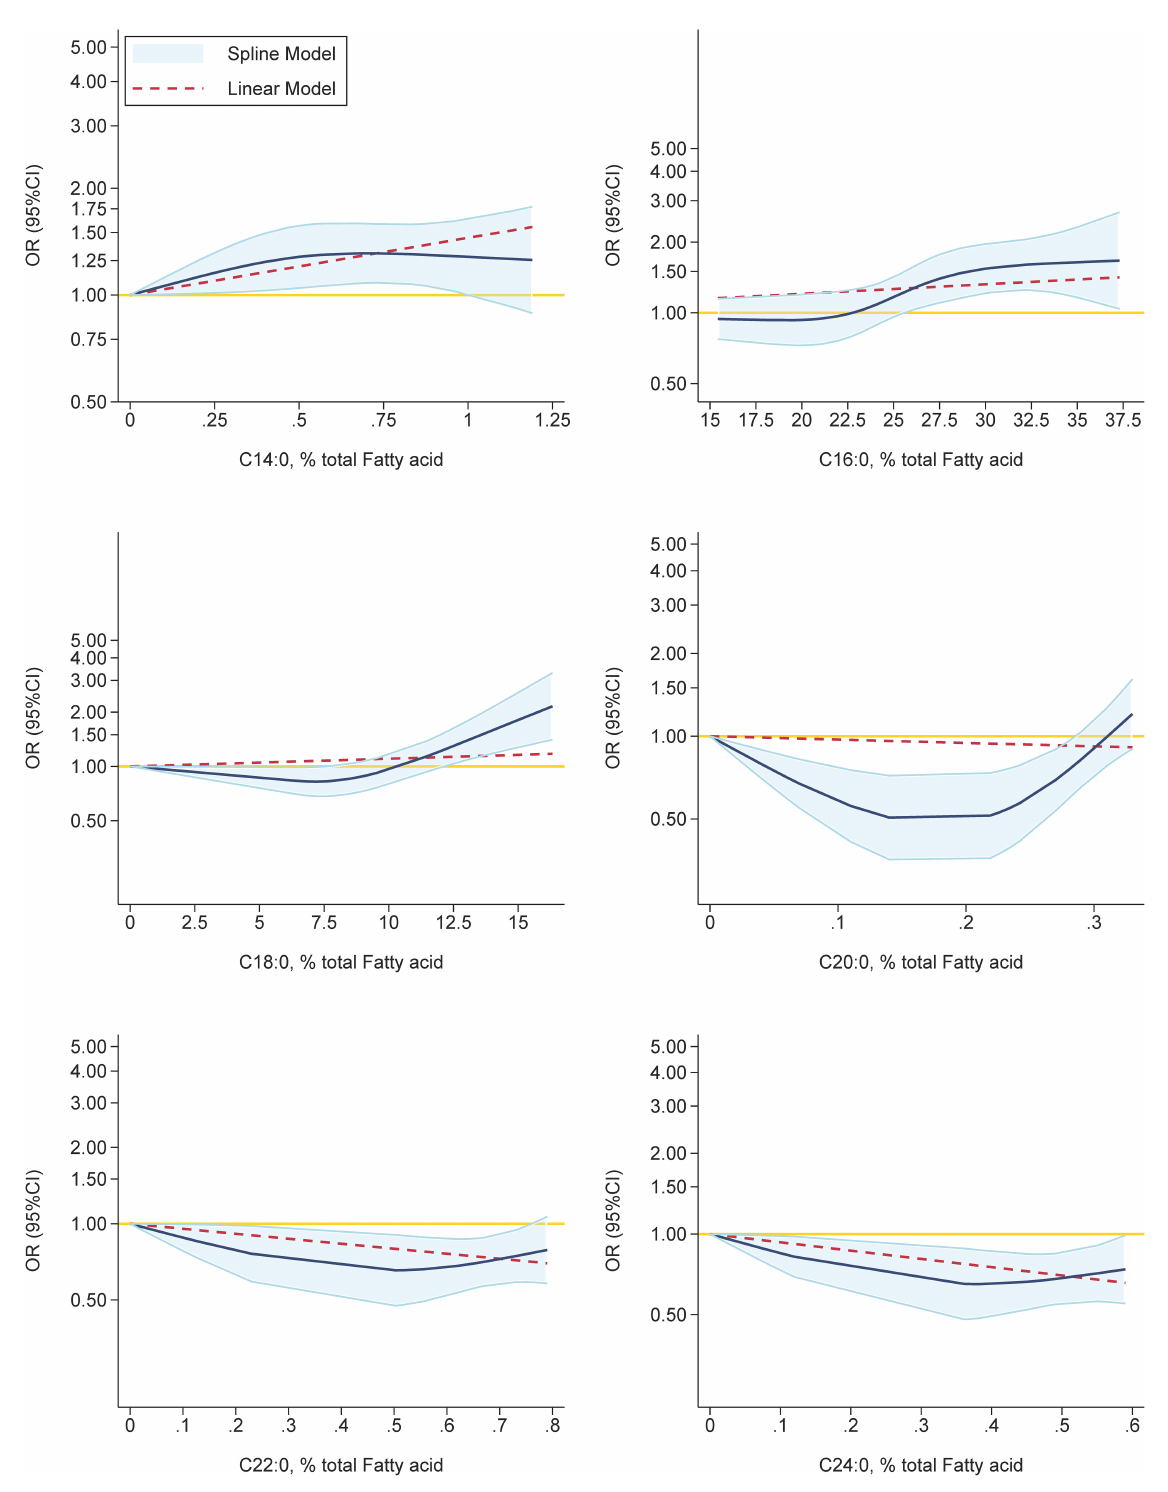
FIGURE6 Dose-response meta-analysis for associations between SFAs and the prevalence of GDM based on data from prospective studies. The pooled OR trends by SFAs’ percentage (solid navy-blue lines) and their 95% CIs (light-blue areas) were obtained by random-effects dose–response meta-analysis. The dashed red lines represent the linear trend. The circles represent ORs according to the specific fatty acid’s categories from each study. The yellow line was the horizontal reference line ( Y =